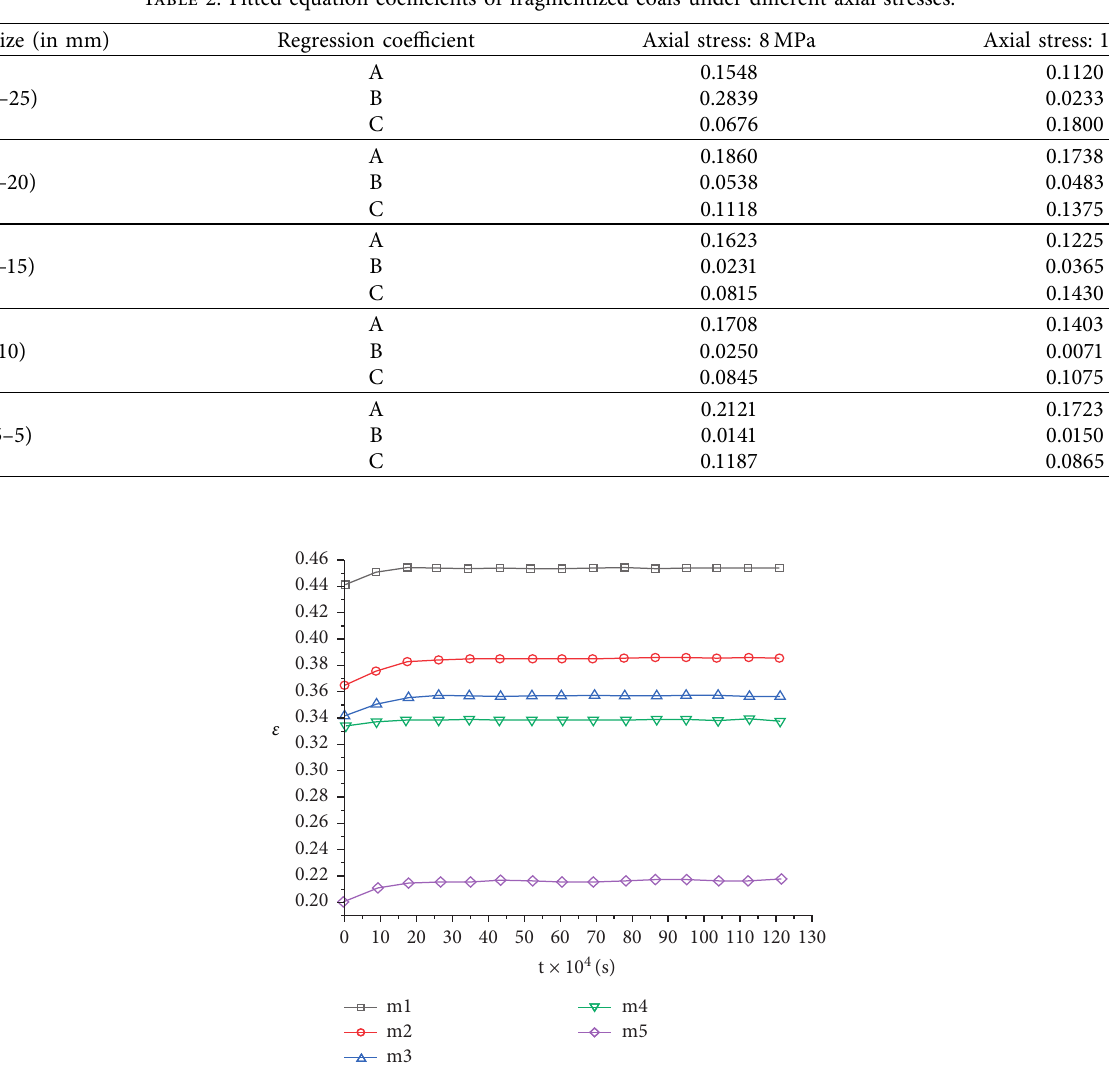
Figure 6: The ε- t relation of fragmentized coals with different grain sizes under the stress of 12MPa.